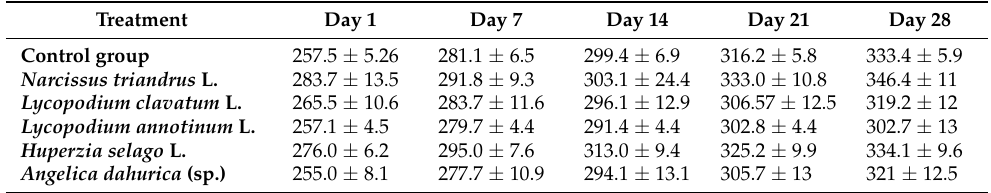
Table 1. The average weight of rats [g] measured every 7 days during the experiment. Data are presented as the means ± SEM ( n = 7).